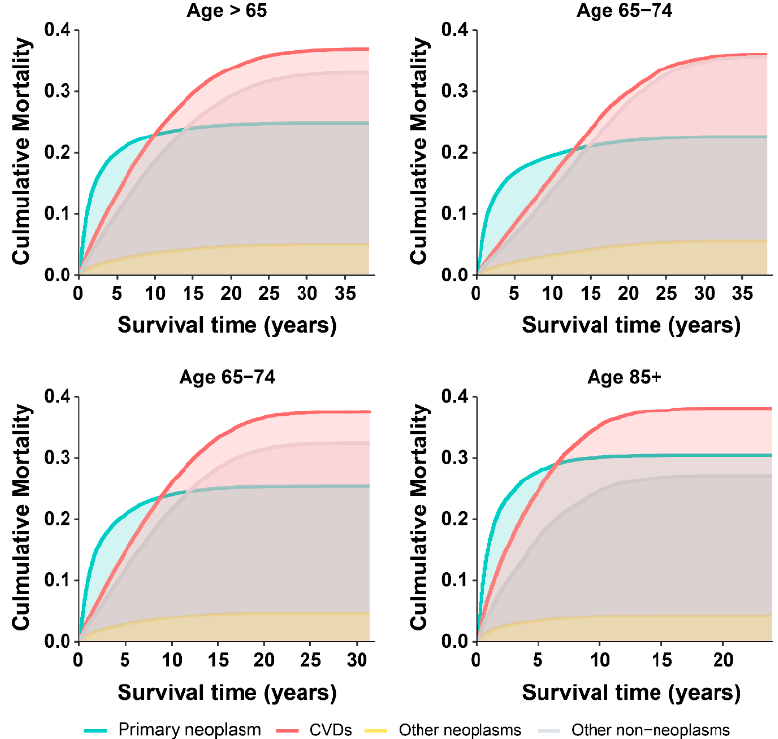
Figure 2. Cumulative mortality among older patients ( ≥ 65 years) with bladder cancer.